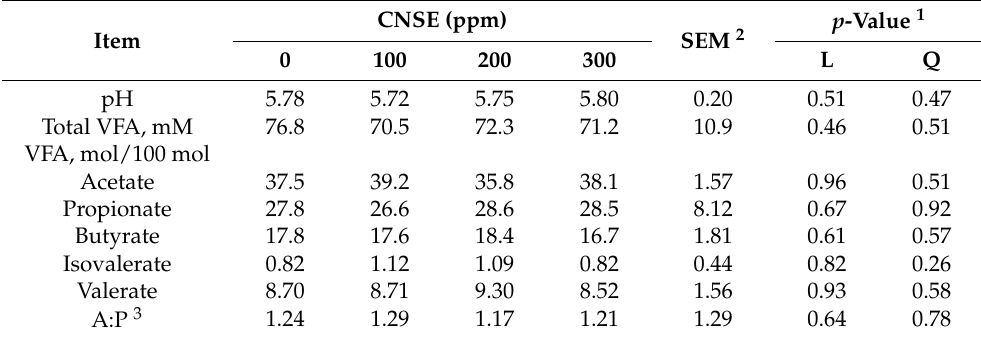
Table 3. E ff ect of di ff erent levels of CNSE supplementation on continuous culture fermenters me- tabolites. Table 3. Effect of different levels of CNSE supplementation on continuous culture fermenters metabolites.